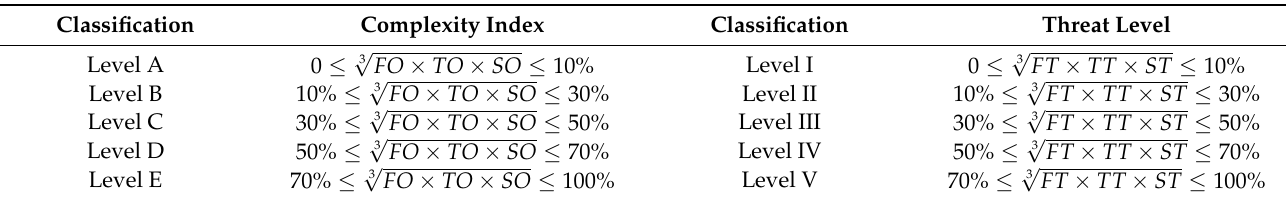
Table 3. Classification standards for electromagnetic